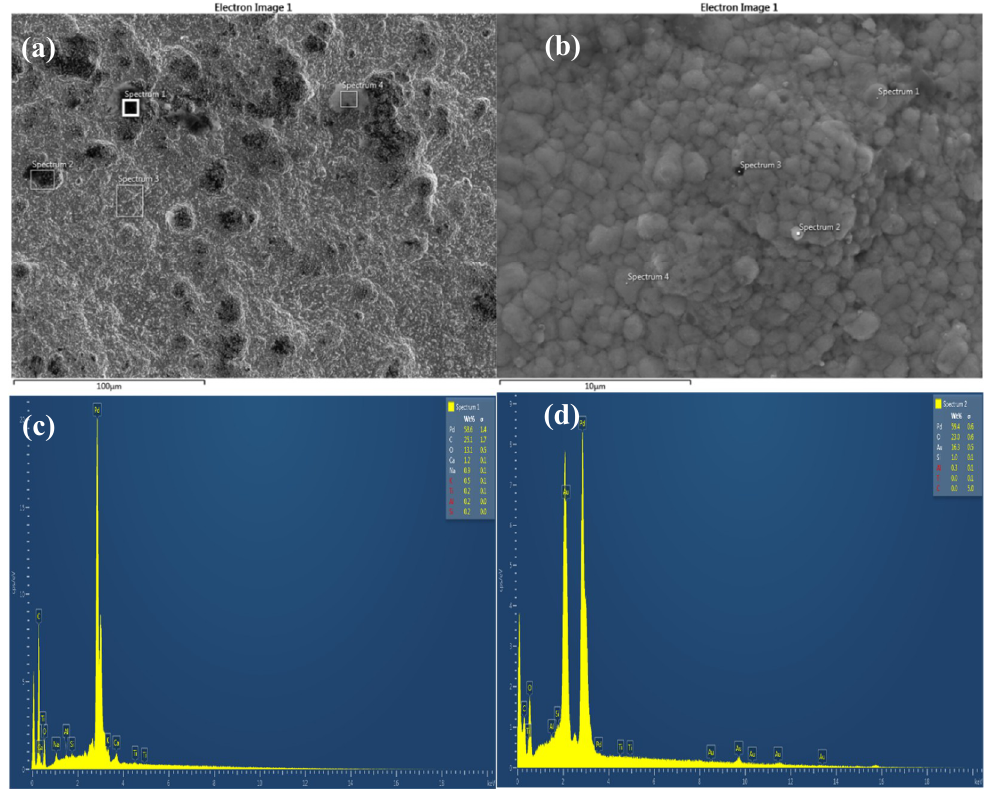
Figure 14. EDS analysis of the surface composition for Pd ( a , c ), and Pd-Au ( b , d ) membranes.